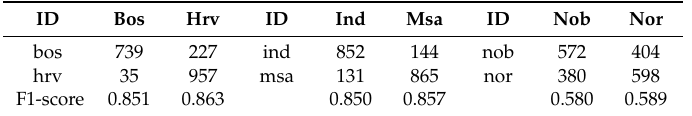
Table 21. Confusion matrix and F1-score related to similar languages in three-stage